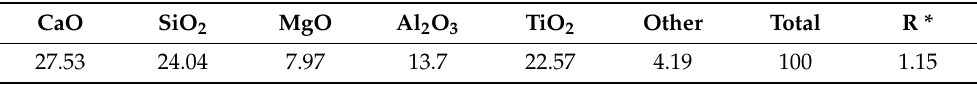
Table 1. The typical compositions of titanium-bearing blast furnace slag in Panzhihua Iron and Steel Group (wt.%). CaO SiO 2 MgO Al 2 O 3 TiO 2 Other